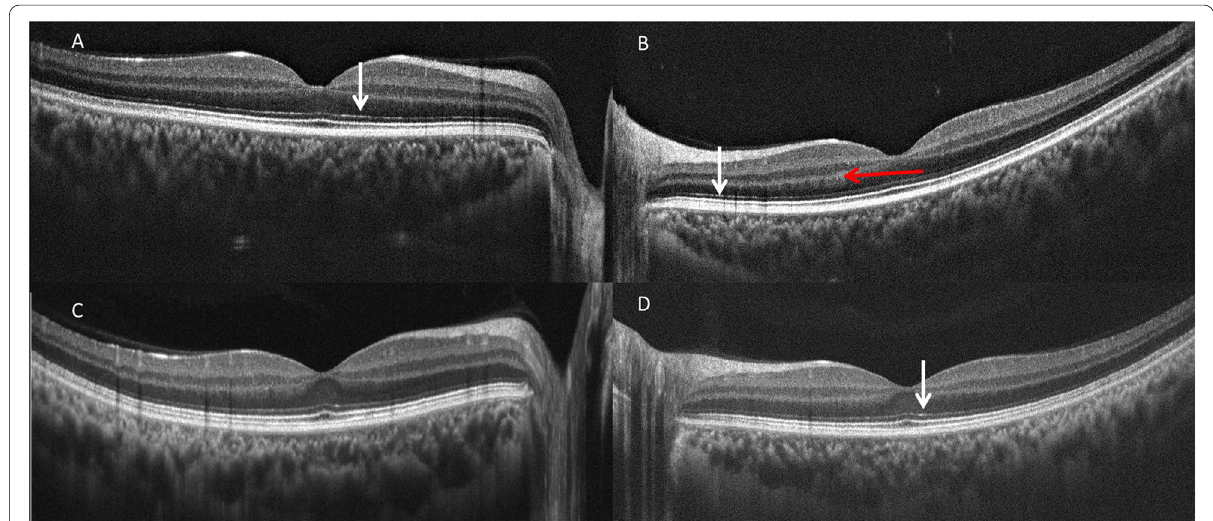
Fig. 2 Spectral domain optical coherence tomography finding of macular area in a representative patient with coronavirus disease 2019. Note marked thickening of the choroid, the hyperreflective bands in outer nuclear layer/ outer plexiform layer (red arrow) and the external limiting membrane (vertical white arrow)